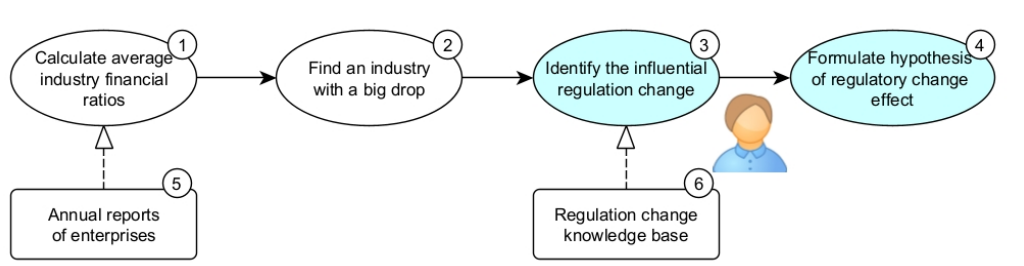
Figure 4. Extended model (Part I) – the expert method